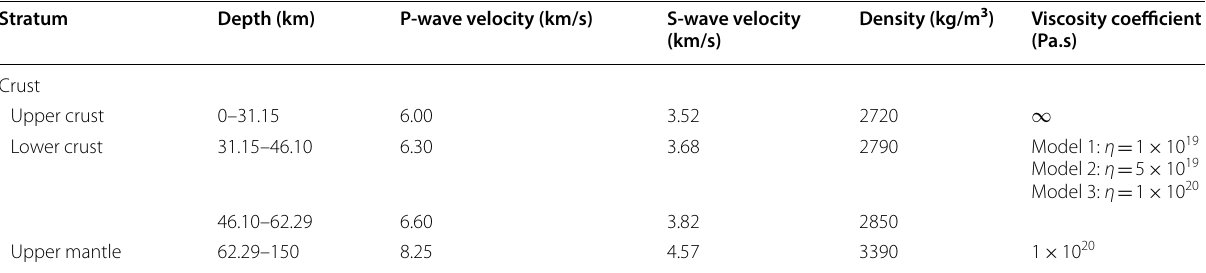
Table 3 Stratified model composed of elastic upper crust, viscoelastic lower crust and viscoelastic mantle